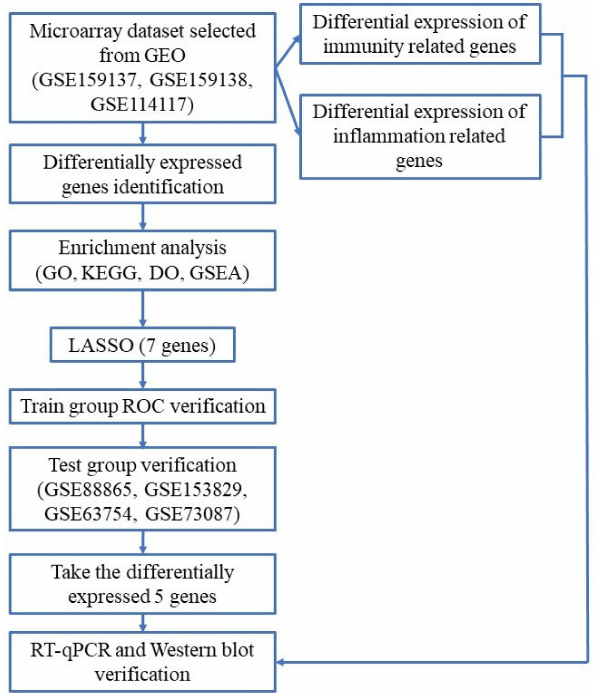
Figure 1. Workflow chart of data generation and